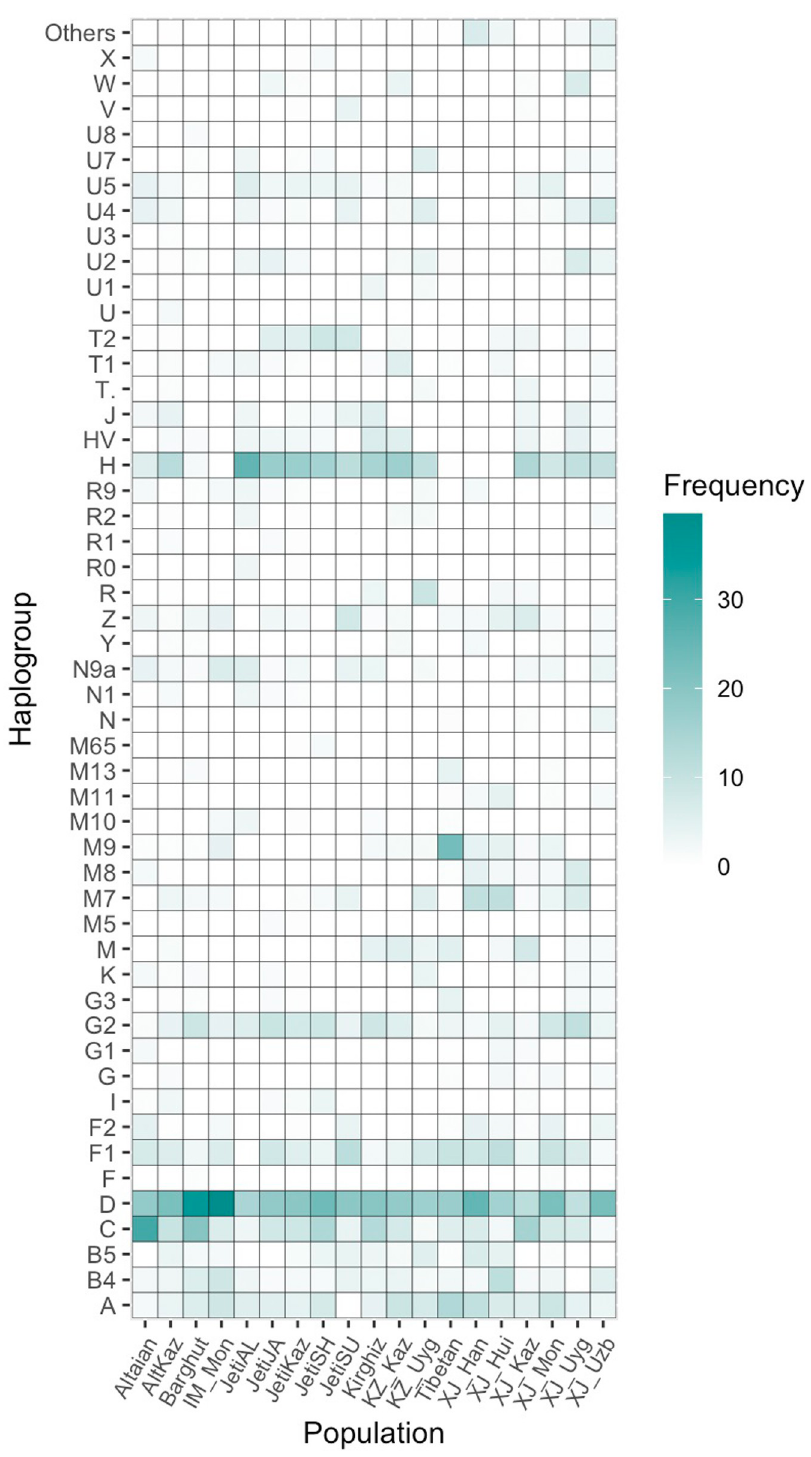
Fig 3. A heatmap for the mtDNA haplogroups and their relative frequencies. Notes on Fig 3: the heatmap was generated for the haplogroup frequency data that was used for PCA analysis in Fig 2.